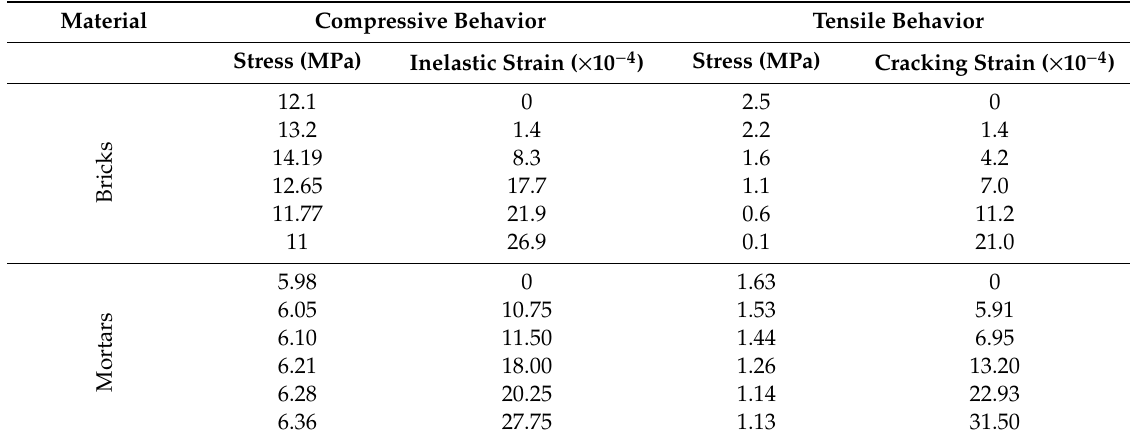
Table 10. Compressive and tensile Behavior of brick and mortar.